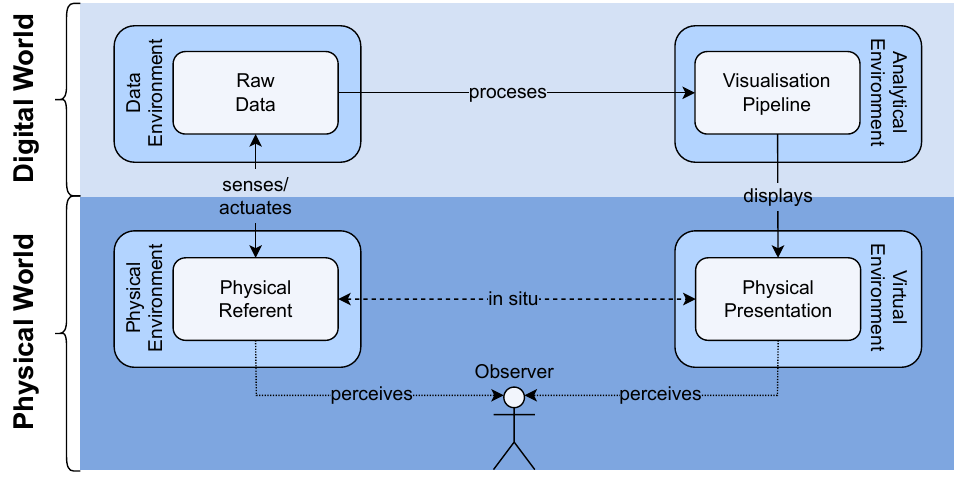
Figure 7. Situated Analytics [19,126] within a DT context . Situated Analytics use the Digi- tal/Physical Divide to define the generative steps in situ in immersive analytics in the physical world (bottom row) or digital world (top row). There is a remarkable similarity between the compo- nents of DTs (blue boxes) and the generation of Situated Analytics (white boxes). The mapping is visually nested to be highlight. An observer in the physical world sees the physical referent or PT (in the DT context). The observer also sees the physical presentation of information (Virtual Environment of a DT). In the digital world, the raw data are received from the referent, which covers the processes of gathering data by the Physical Environment and storing data by the Data Environment. The Visualisation Pipeline produces a visual output (Analytical Environment of a DT). Lastly, the data are placed into the physical presentation (Virtual Environment). Generated with